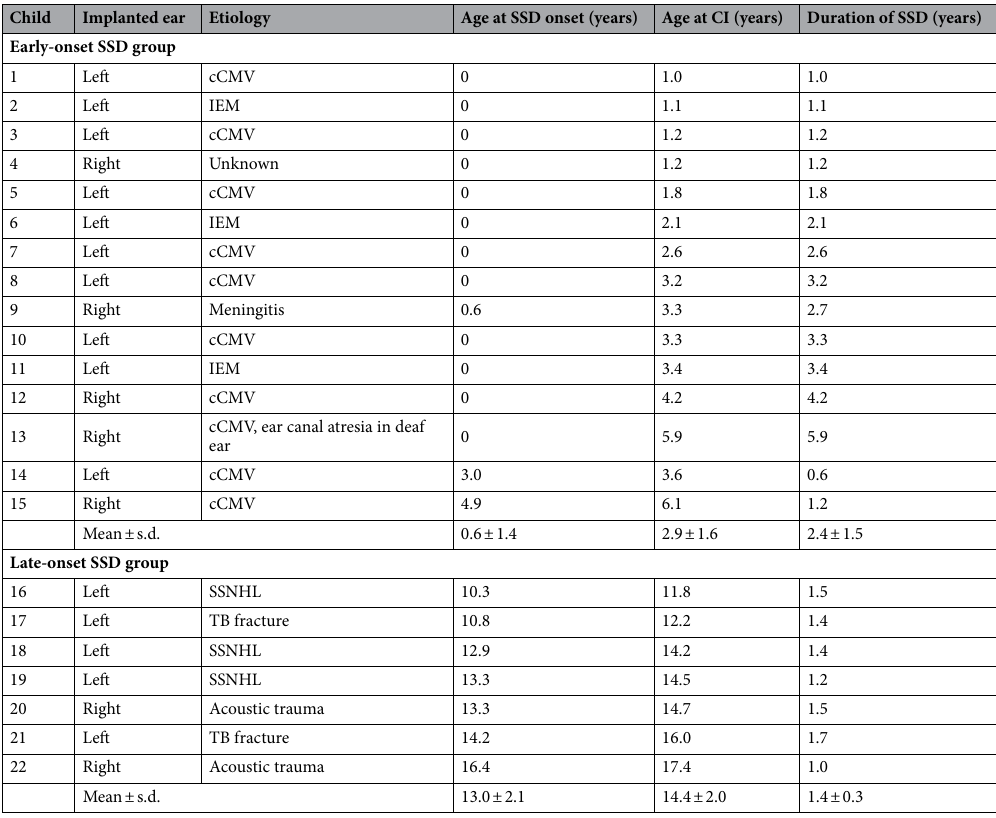
Table 1. Patient demographics. SSD single-sided deafness, cCMV congenital cytomegalovirus, IEM inner ear malformation, SSNHL sudden sensorineural hearing loss, TB fracture temporal bone